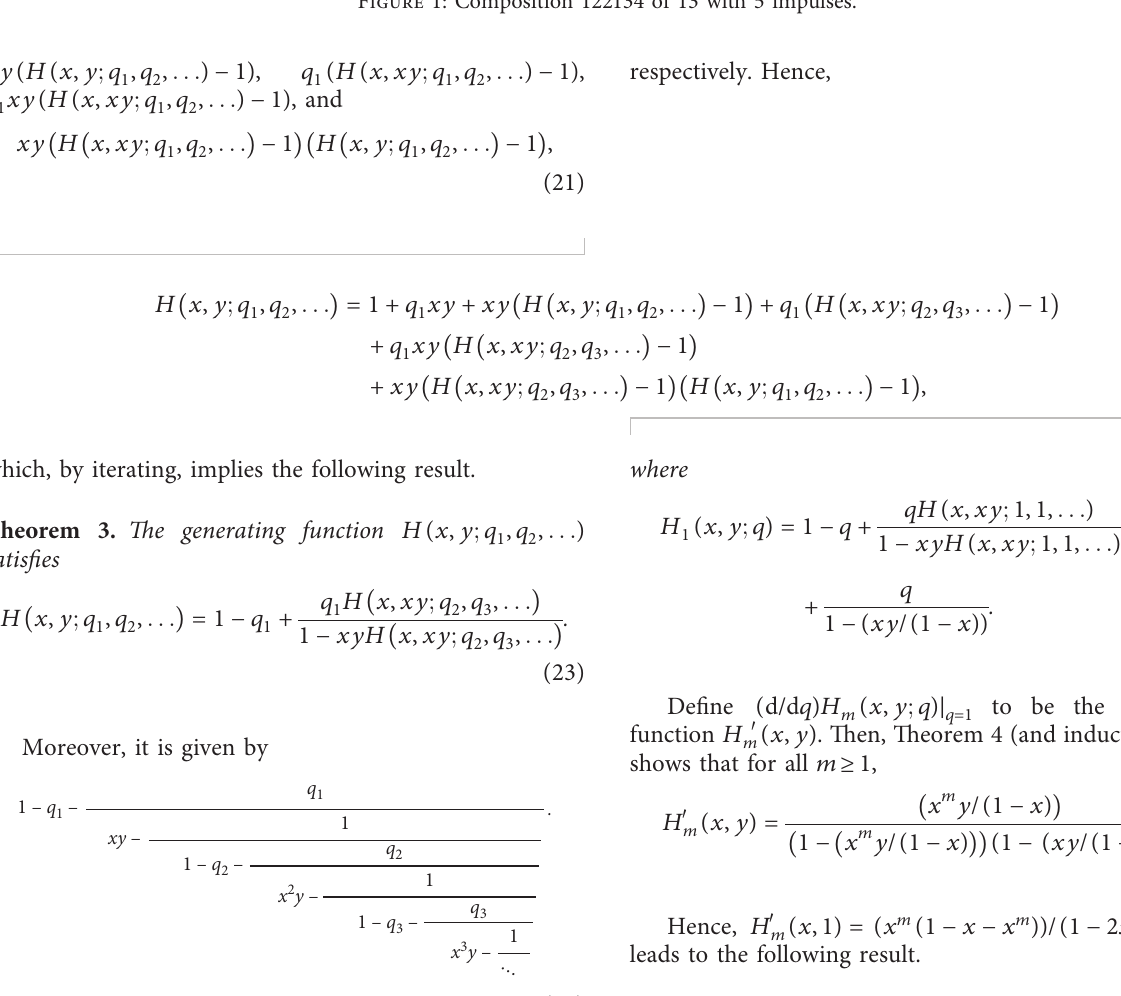
Figure 1: Composition 122134 of 13 with 5